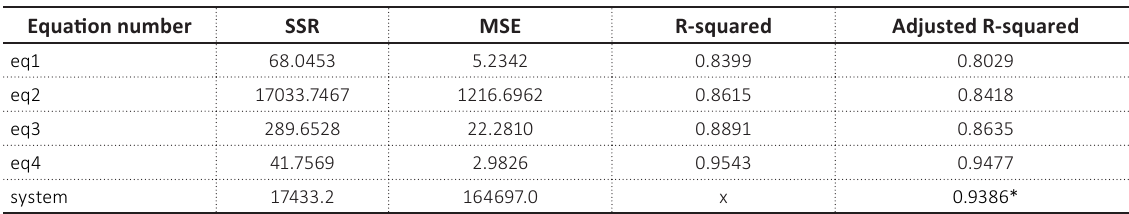
Table 6. Summary statistics for the system of inflation targeting models with simultaneous equations in Ukraine (periods when cpi >